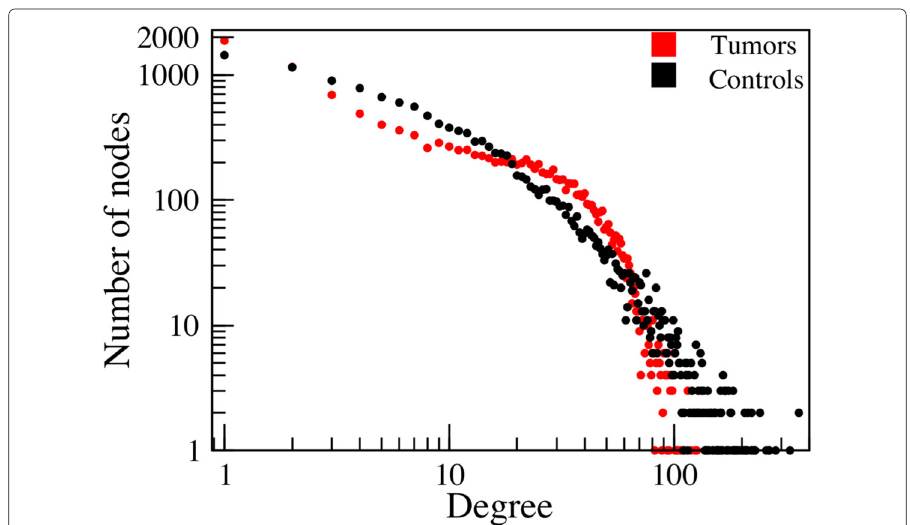
Fig. 3 Degree distributions for both networks. Red dots form the histogram of tumor network, meanwhile black dots take account for control network. Red dots appear to have two different regimes, with a crossover phenomenon. Black dots, on the other hand, appear to follow a power-law with a single scaling exponent